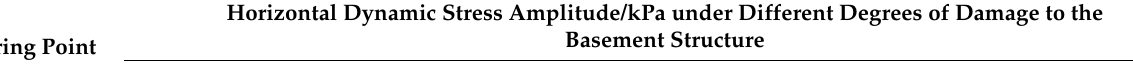
Figure 10. Horizontal dynamic stress amplitudes diagram of measuring points 2, 3, and 4 under different basement hanging ranges. Table 11. Horizontal dynamic stress amplitudes of measuring points 2, 3, and 4 under different basement hanging ranges. Measuring Point Table 12. Horizontal dynamic stress amplitudes of measuring points 2, 3, and 4 under different degrees of damage to the foundation structure.